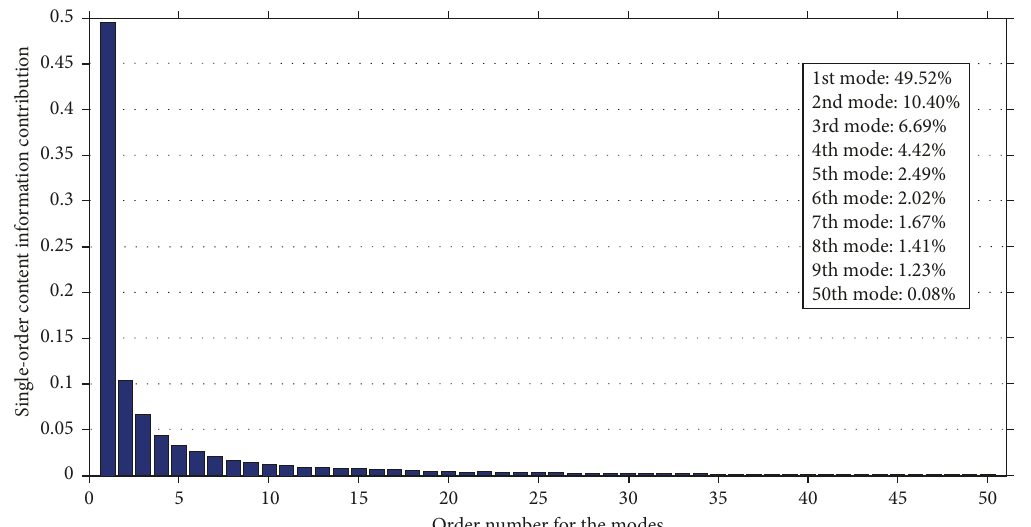
Figure 10: Single-order content information contribution for the first 50 modes in the initial stage of flame propagation.